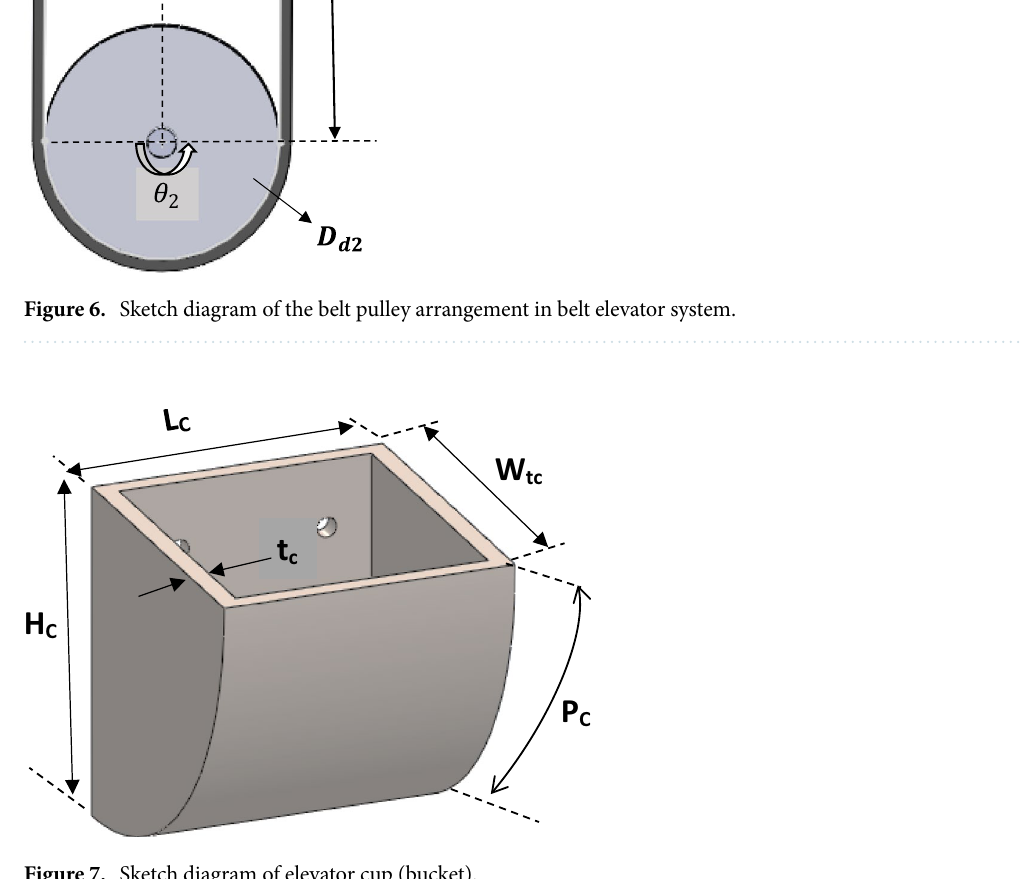
Figure 7. Sketch diagram of elevator cup